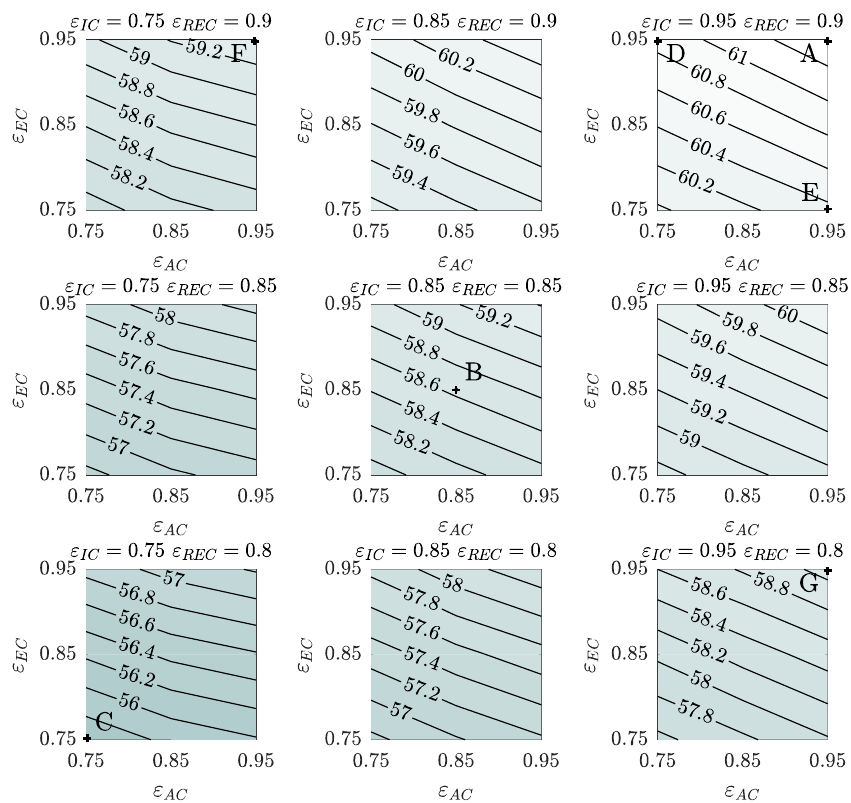
Figure 3. Cycle thermal efficiency across the design space as a function of the heat exchanger effectiveness— OPR = 40 & ∆ T ps = 5 K.